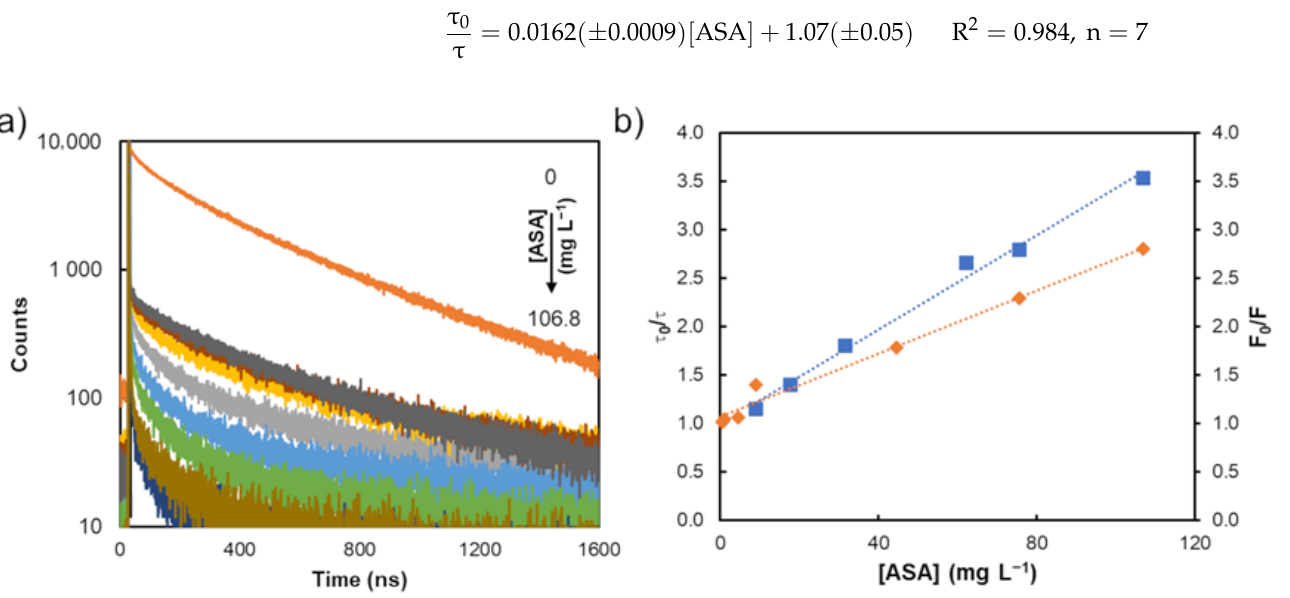
Figure 5. ( a ) PL decay curves of the MPA-AIS QDs ( λ em = 665 nm) in the absence and presence of increasing concentration of ASA. ( b ) Stern–Volmer plots displaying PL lifetimes ratio (orange diamonds) and the ratio of the PL intensities (blue squares).